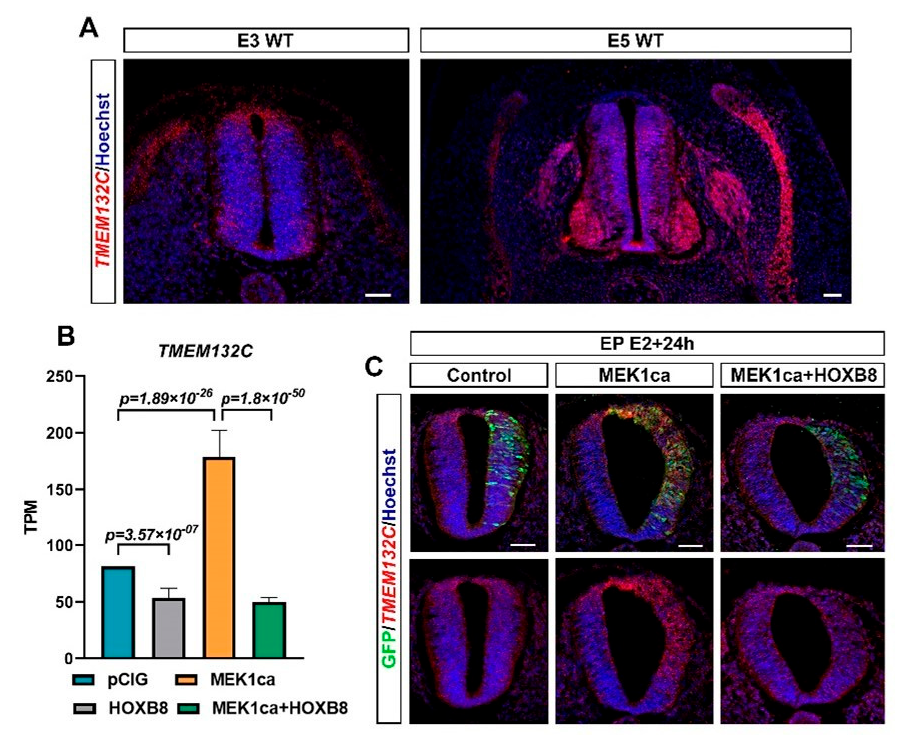
Figure 4. TMEM132C regulation by MEK1ca and HOXB8. ( A ) Fluorescence in situ hybridization with the TMEM132C probe on transverse trunk sections of wild-type chicken embryos at E3 and E5. ( B ) Mean expression of TMEM132C in TPM (transcripts per kilobase million) obtained for the two replicates of the control- (pCIG1, pCIG2), HOXB8- (HOXB8-1 and HOXB8-2), MEK1ca- (MEK1ca-1 and MEK1ca-2) and MEK1ca + HOXB8 (MEK1ca + HOXB8-1 and MEK1ca + HOXB8-2)-expressing samples, with the corresponding p-value according to the DGE of each pair. ( C ) Fluorescence in situ hybridization with the TMEM132C probe and immunofluorescence staining with the anti-GFP antibody on transverse trunk sections of chicken embryos one day post-electroporation in the pCIG, HOXB8, MEK1ca and MEK1ca + HOXB8 conditions. 30.4% (704/2316) of the genes (clusters 6–8) behaved oppositely to the genes of clusters 1–5: their expression was downregulated by MEK1ca (MEK1ca versus pCIG) and reversed by HOXB8 (upregulated in “MEK1ca + HOXB8 versus MEK1ca”), and thus